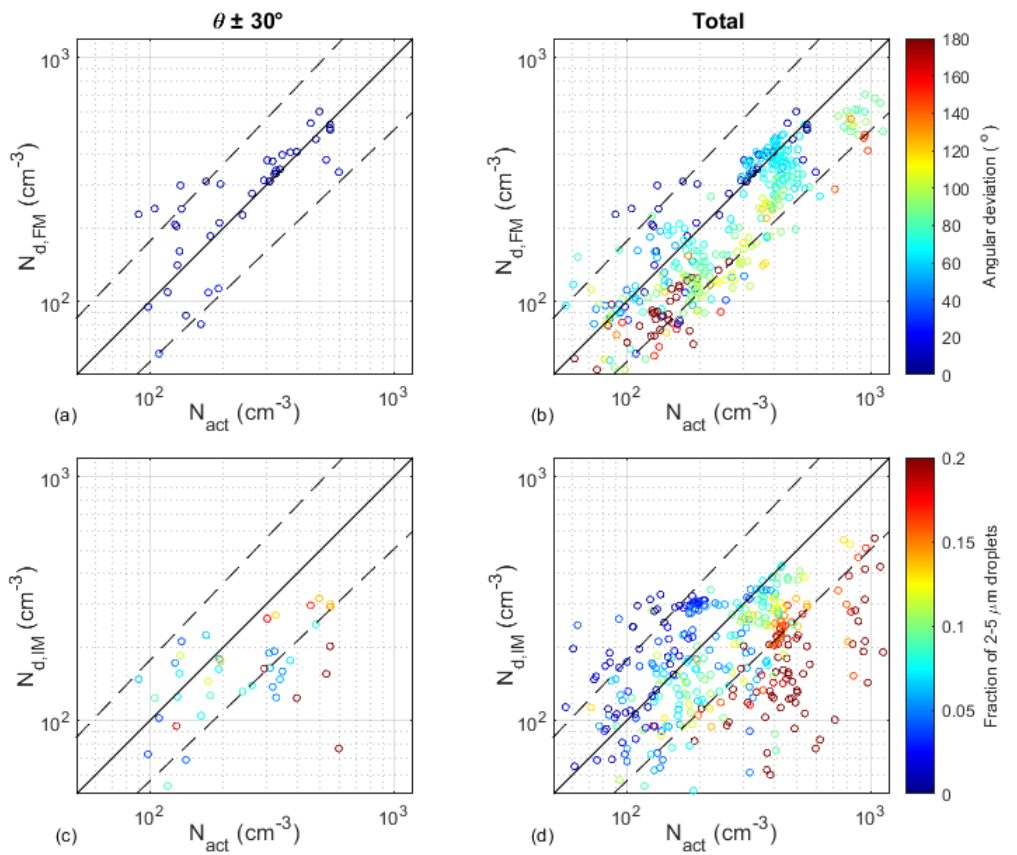
Figure 8. Comparison of activated particle concentrations ( N act ) with measured cloud droplet number concentrations ( N d ) using FM-120 (a, b) and ICEMET (c, d) by angular deviation ( θ ) of 30 ◦ and for the total data set ( θ ± 180 ◦ ). Panels (a) and (b) are colored by angular deviation from the isoaxial sampling ( θ ) and panels (c) and (d) using a fraction of the lowest bins 1–3 ( N d , FM2 − 5 ). Black lines represent 1 : 1 (solid), 1 : 2 (dashed) and 2 : 1 (dashed) values. Only the data points where the fraction of the smallest bins is low ( N d , FM2 − 5 < 0 . 2) are